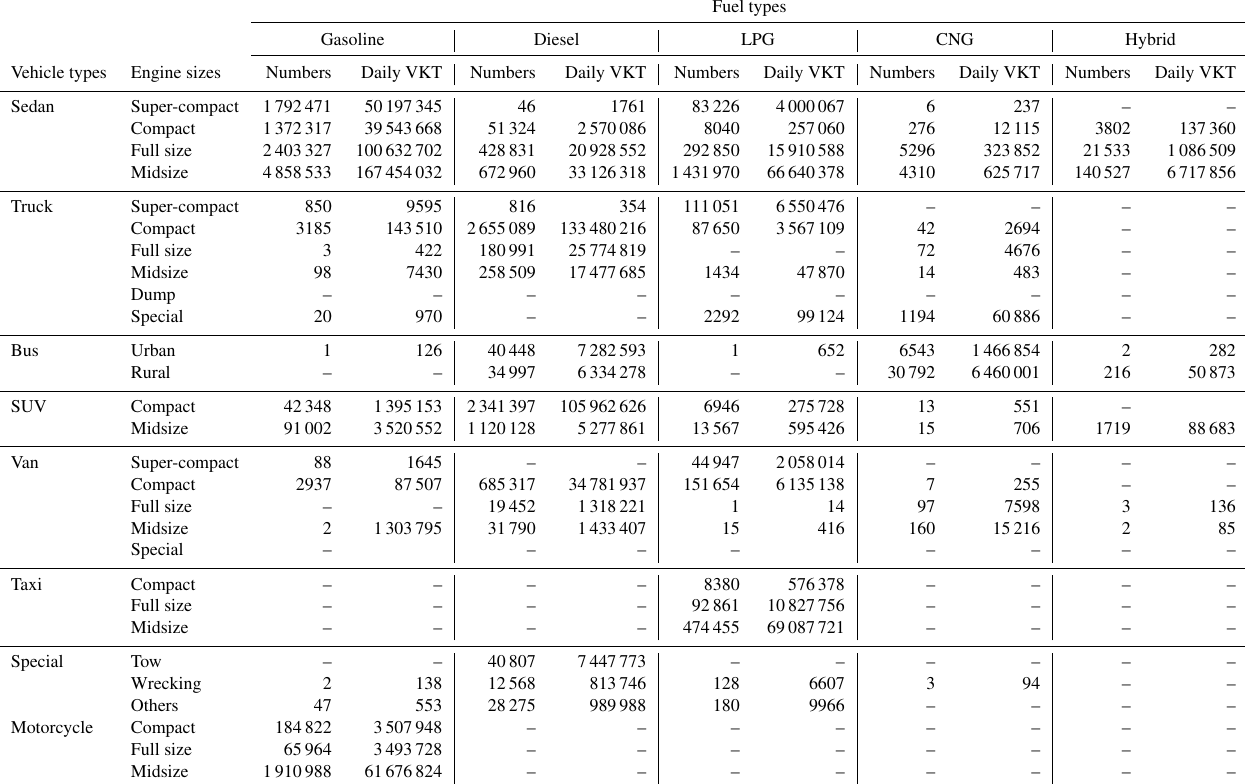
Table B1. A summary of the activity data (number of vehicles and daily total VKTs) in South Korea by vehicle type and engine size.